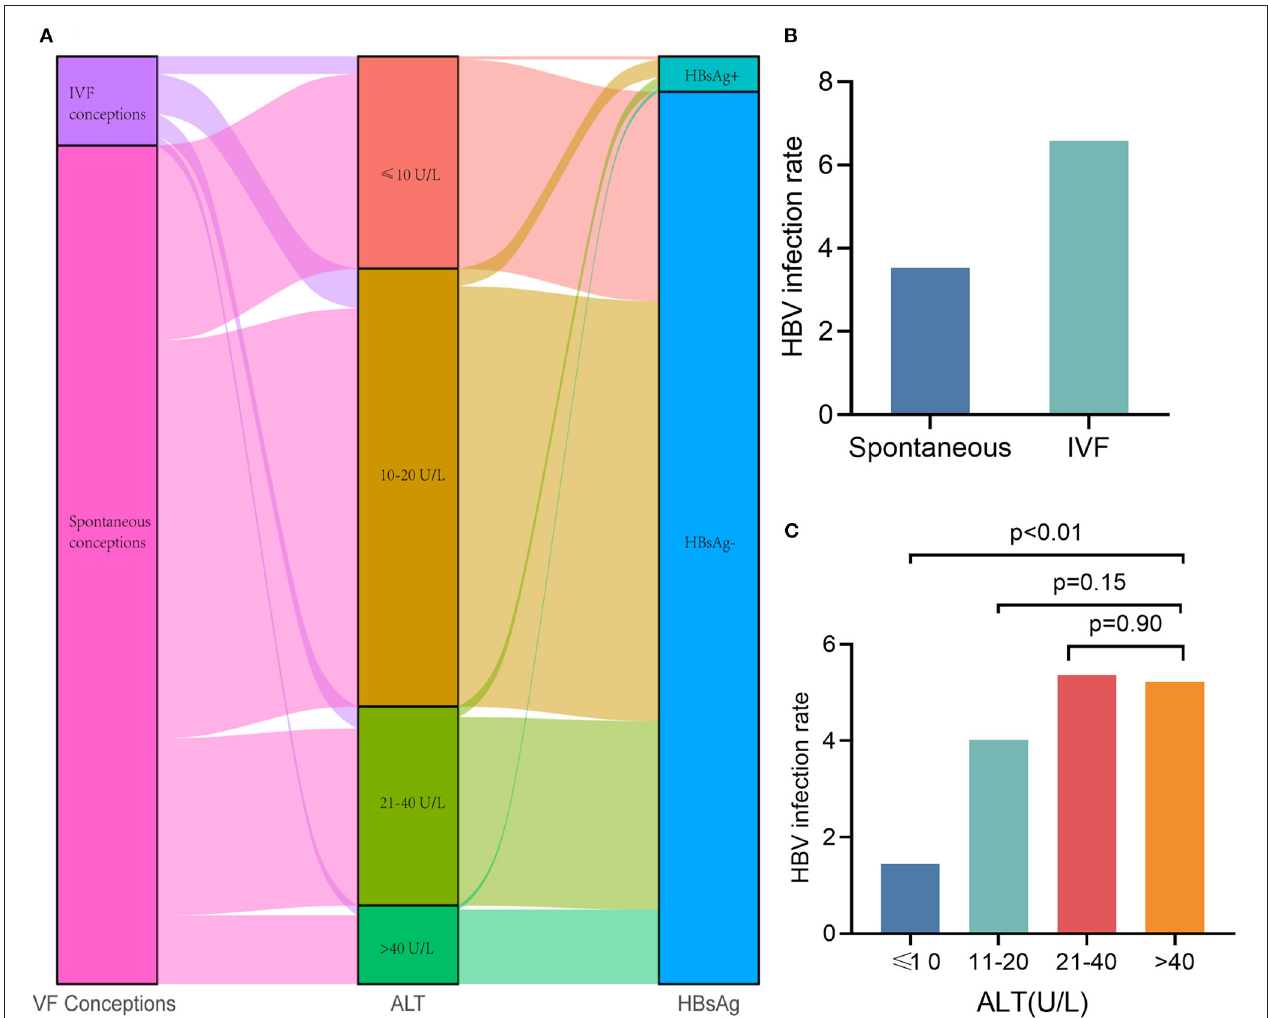
FIGURE 5 | Hepatitis B infection does not affect NIPS test failure. (A) Sankey diagram showing sample conception pattern, ALT categories and HBV infection. (B) The HBV infection rate in IVF conceptions was significantly higher than that in spontaneous conceptions. (C) The HBV infection rates with ALT categories were 1.43, 4.02, 5.36, and 5.22%,